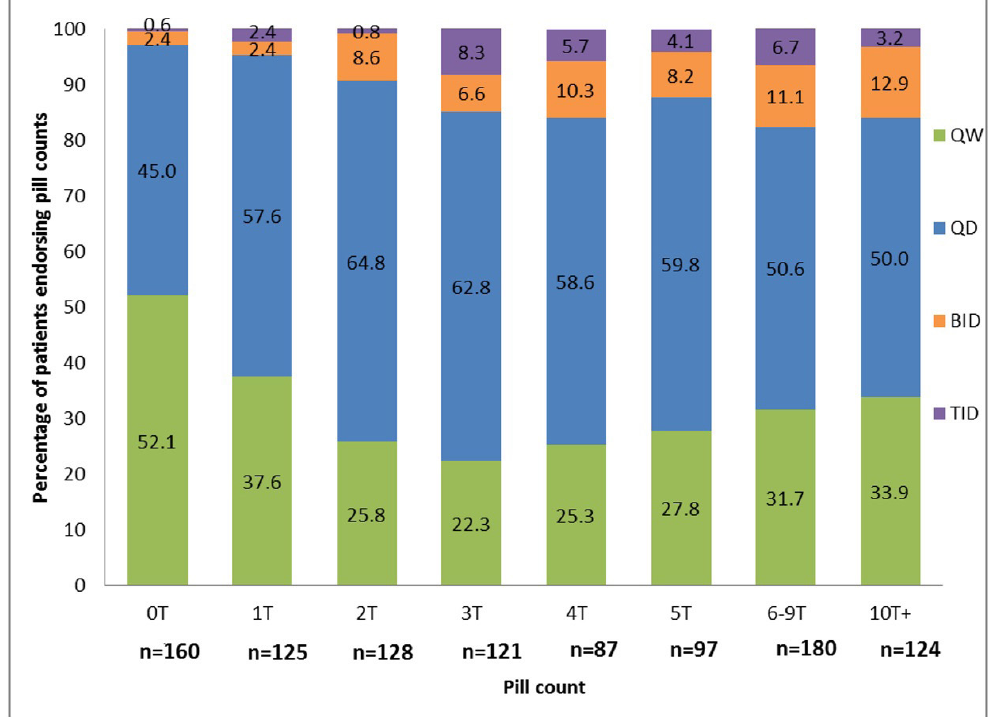
Figure 3. Frequency of Dosing Preference by Number of Pills